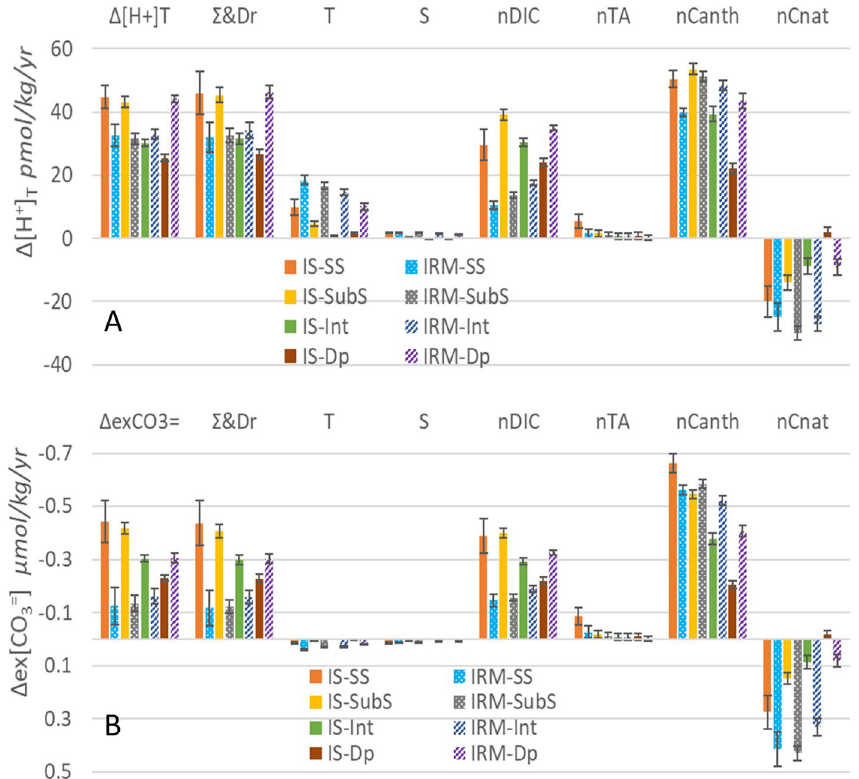
Figure 6. Acidification trends and drivers decomposition (T,S, nDIC and nTA) for the seasonally detrended average time series of total hydrogen ions concentration in pmol/kg/yr (Δ [H + ] T , A ) and for excess of [CO 3 = ] over the [CO 3 = ] at aragonite saturation in µmol/kg/yr (Δ ex[CO 3 = ] , B ). The nDIC driver trends is split in natural (nCnat) and anthropogenic components (nCanth). The colour code is shown on both